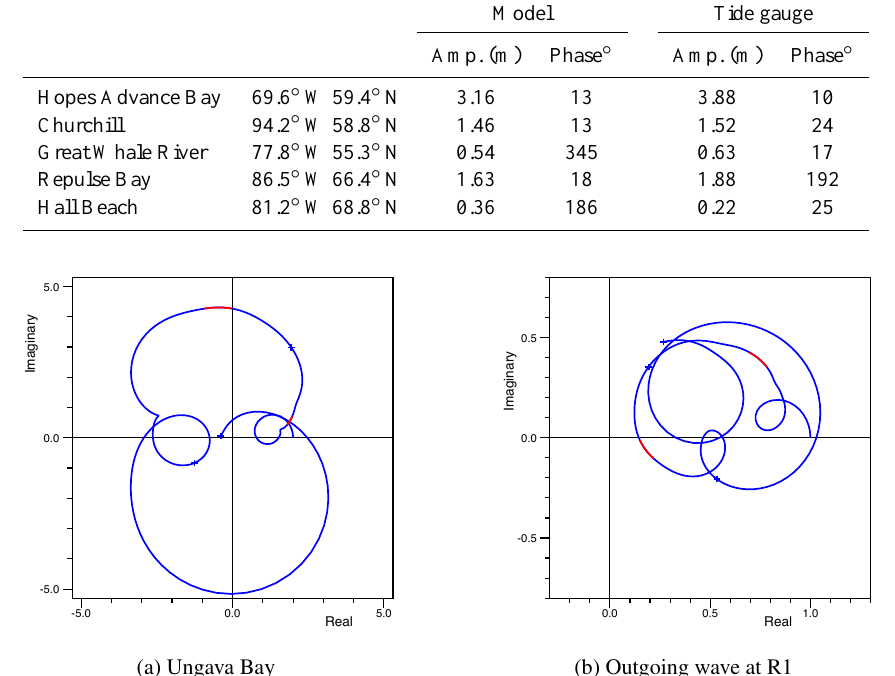
5.0-5.0 -5.0 0.0